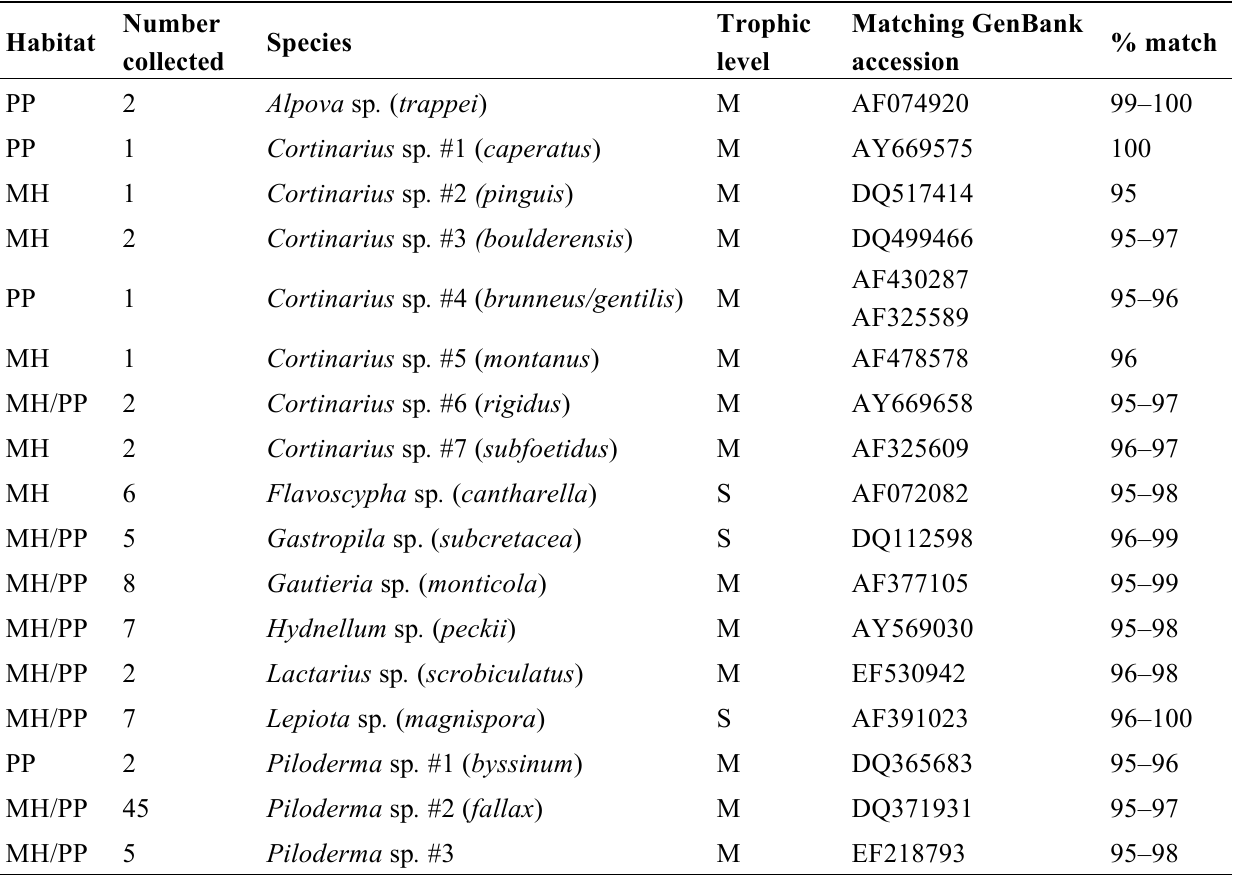
Table 2. Mat fungi from Crater Lake National Park. PP = ponderosa pine